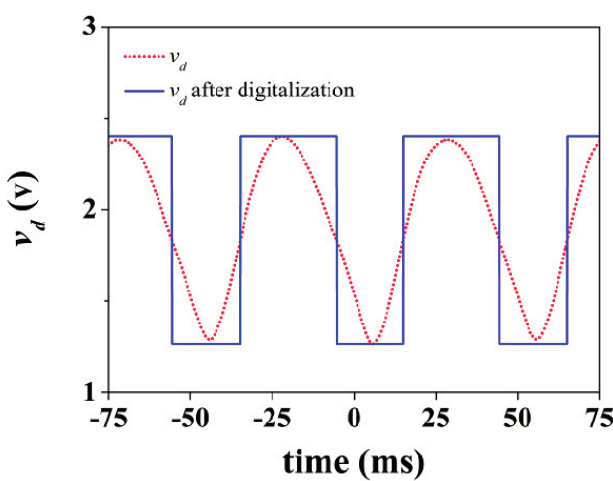
Figure 17. Output waveform for an angular velocity of 600